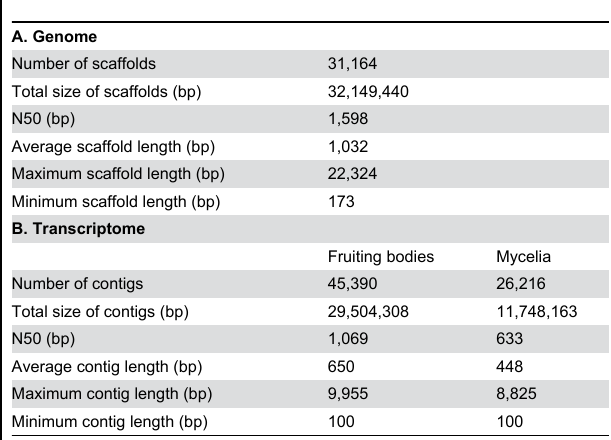
Table 2. Assembly